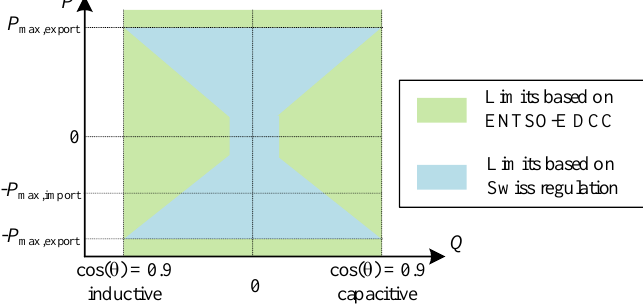
Figure 5. Admissible reactive power exchange limits for passive distribution systems [12], as prescribed by the Swiss regulation and comparison with ENTSO-E DCC.